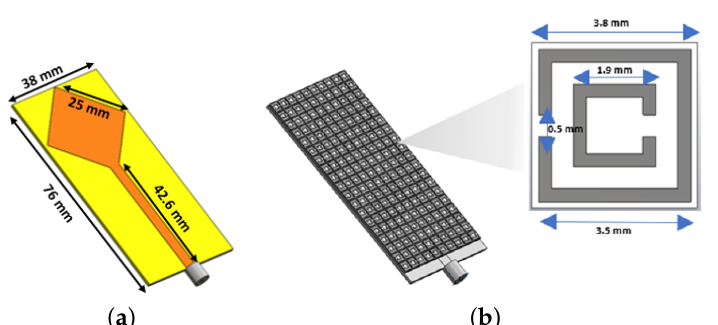
Figure 4. ( a ) Dimensions of PSMA ( b ) PSMA with MTS superstrate loading and square DS-SRR based unit